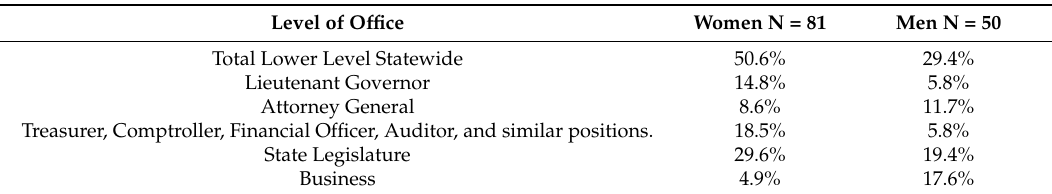
Table 1. Prior political office of non-incumbent gubernatorial